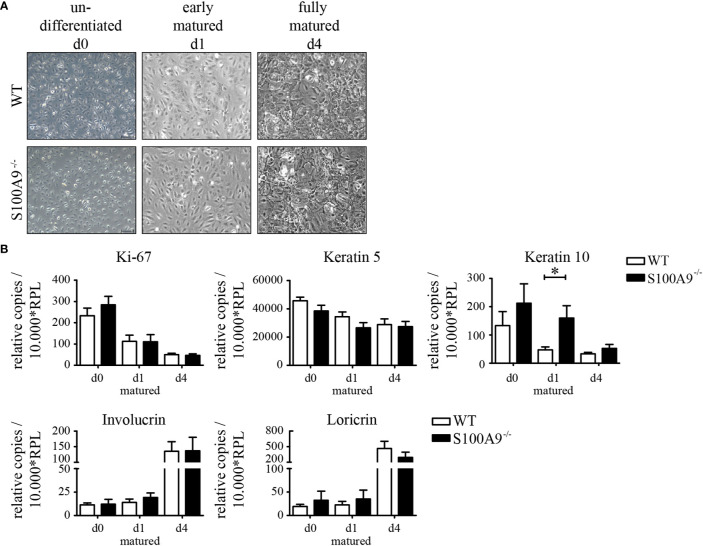
Morphology and differentiation of naïve primary keratinocytes of wildtype and S100A9−/− mice. Primary epidermal keratinocytes were isolated from naïve wildtype C57BL/6 (WT)- and S100A9−/− mice. (A) Representative phase contrast images of primary keratinocytes from WT- and S100A9−/− mice at indicated stages of maturation (original magnification 10 x, scale bar = 100 µm). (B) Quantitative real-time PCR analysis of proliferation and maturation markers in keratinocytes from WT (white column)- and S100A9−/− (black column) mice at indicated stages of maturation. Columns represent means ± SEM of at least eight independent experiments. Values are normalized to RPL housekeeping gene. Time course and cell culture conditions of primary keratinocytes are illustrated in
Supplementary Figure 1
. Student’s t-test *p < 0.05.